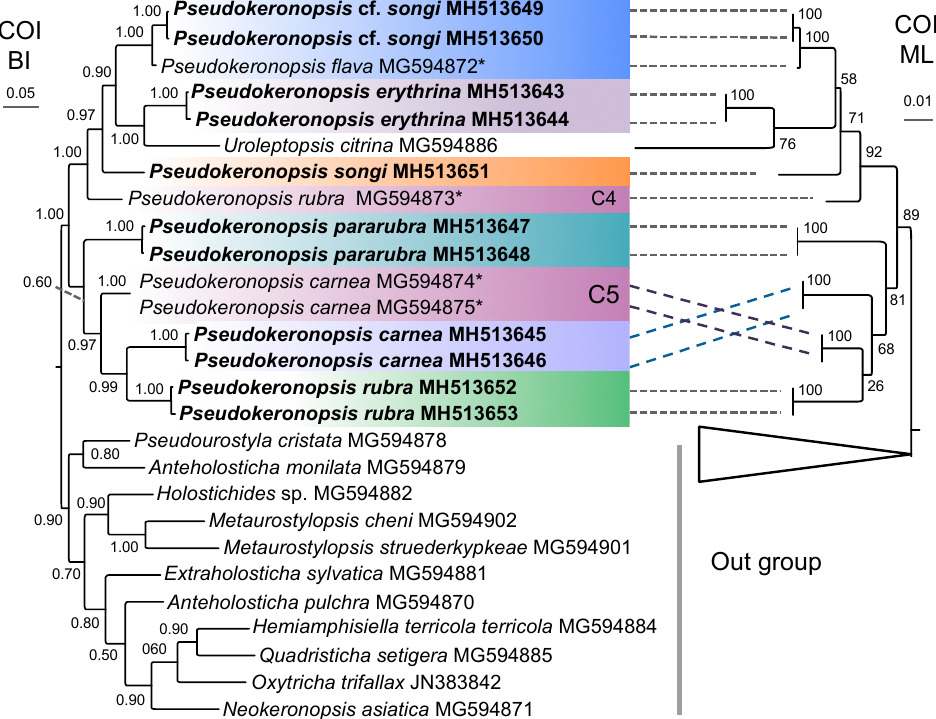
Figure 8. Bayesian inference (BI) and maximum likelihood (ML) trees based on the COI gene showing phylogenetic relationships among the available pseudokeronopsids. Numbers at the nodes represent BI and ML support values. Newly sequenced species are in bold. *, misidentified species.